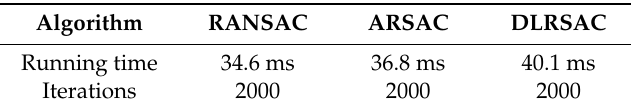
Table 1. The average running time of di ff erent algorithms.